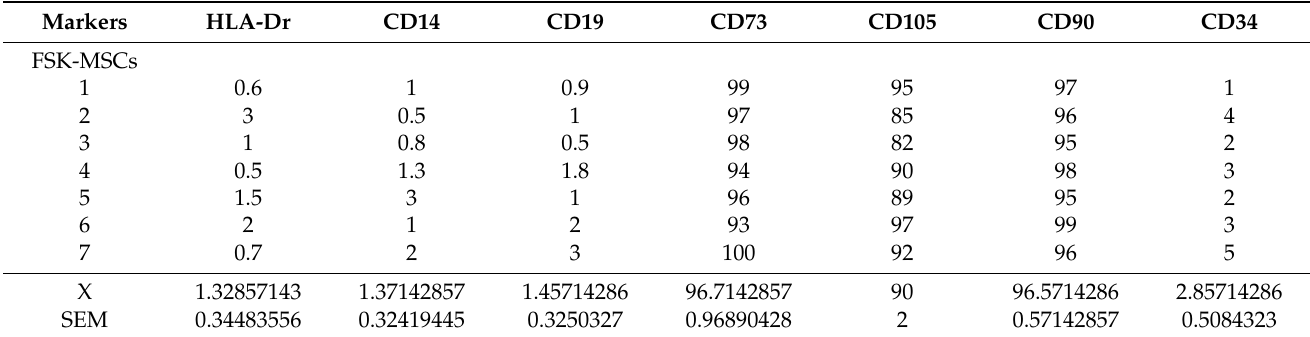
Figure 1. Flow cytometry profile of FSK-MSCs. Human FSK-MSCs were stained with specific fluorochrome-labeled monoclonal antibodies (filled histograms) against CD14, CD19, CD34, CD45, HLA-DR, CD73, CD90, and CD105. In each image, empty histograms show the background staining with the isotype control (control staining), and solid black histograms represent the specific staining for the indicated cell surface markers. For each analysis, the marker is given under the plot. Table 2. The % expression of MSC markers as determined by flow